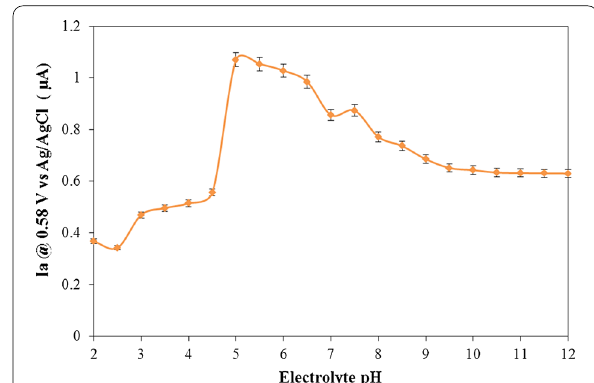
Fig. 9 Anodic current changes at 0.58 V versus Ag/AgCl of ARLD-5